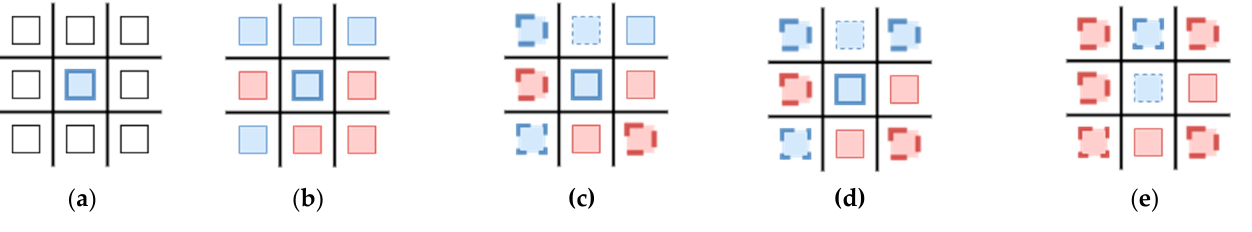
Figure 5. NetLogo Info window. Table 1 shows the individual variable level manipulation and the resultant number of combinations of the simulation experiment. The experimental runs totaled 1890. The results are extracted and tabulated for further statistical analysis. Table 1. ABM experimentation parameters. Neighborhood Influ- ence